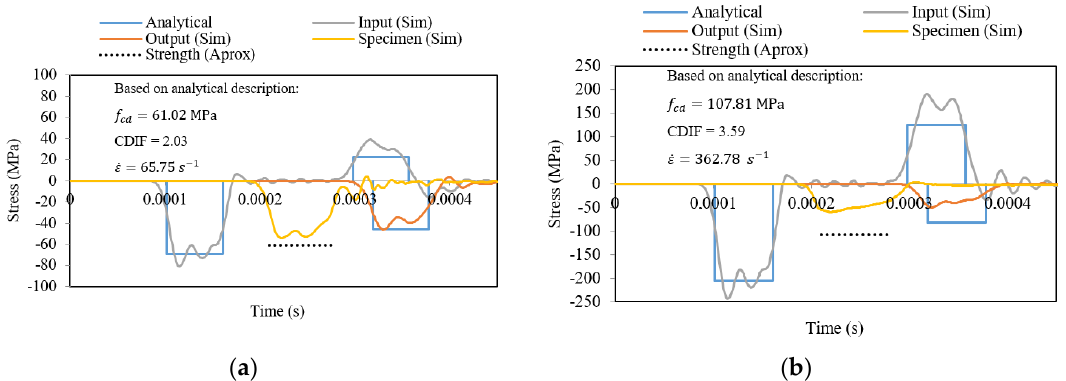
Figure 11. Waves in simulations of dynamic compression using SHPB for parameters from the previous